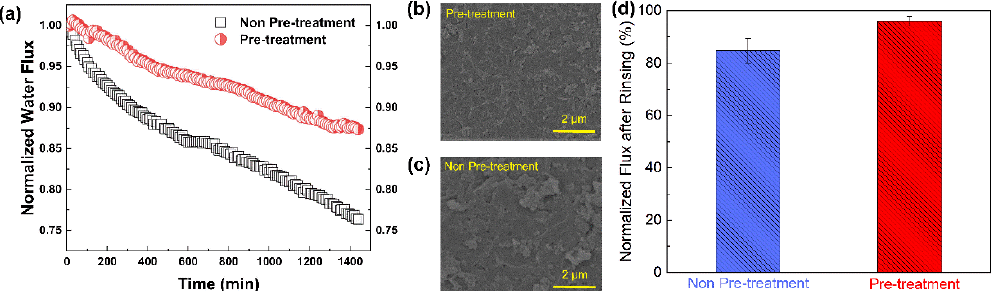
Figure 10. ( a ) Normalized water flux as a function of filtration time for an RO membrane without pretreatment or with pre-treatment of the feed solution with MIL-101(Fe); ( b , c ) Surface SEM images of the RO membrane after filtration; ( d ) Normalized flux after chemical cleaning of the membranes that experienced the silica-scaling experiment.